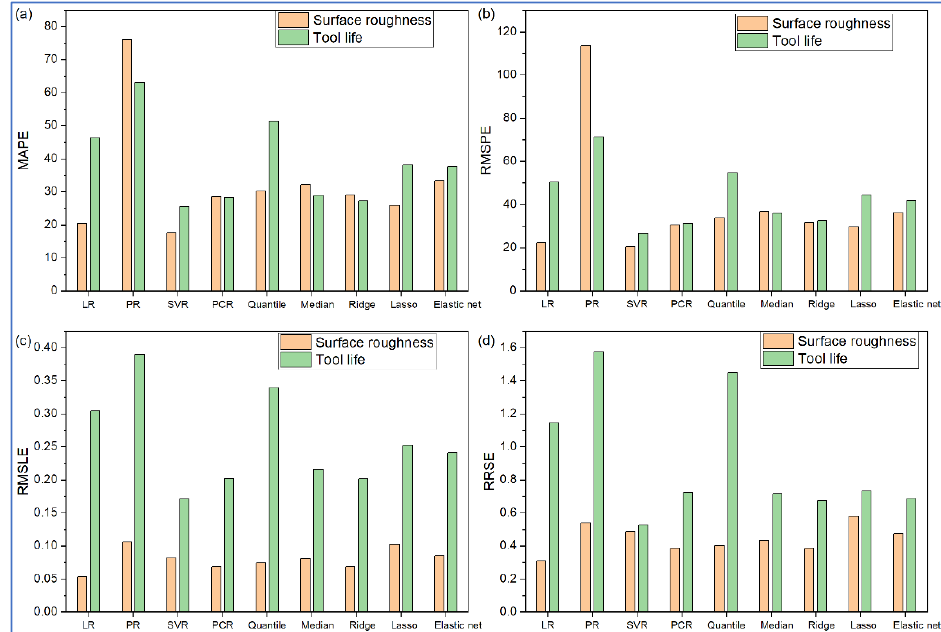
Figure 3. Prediction performance of various regression models for turning. Prediction errors in